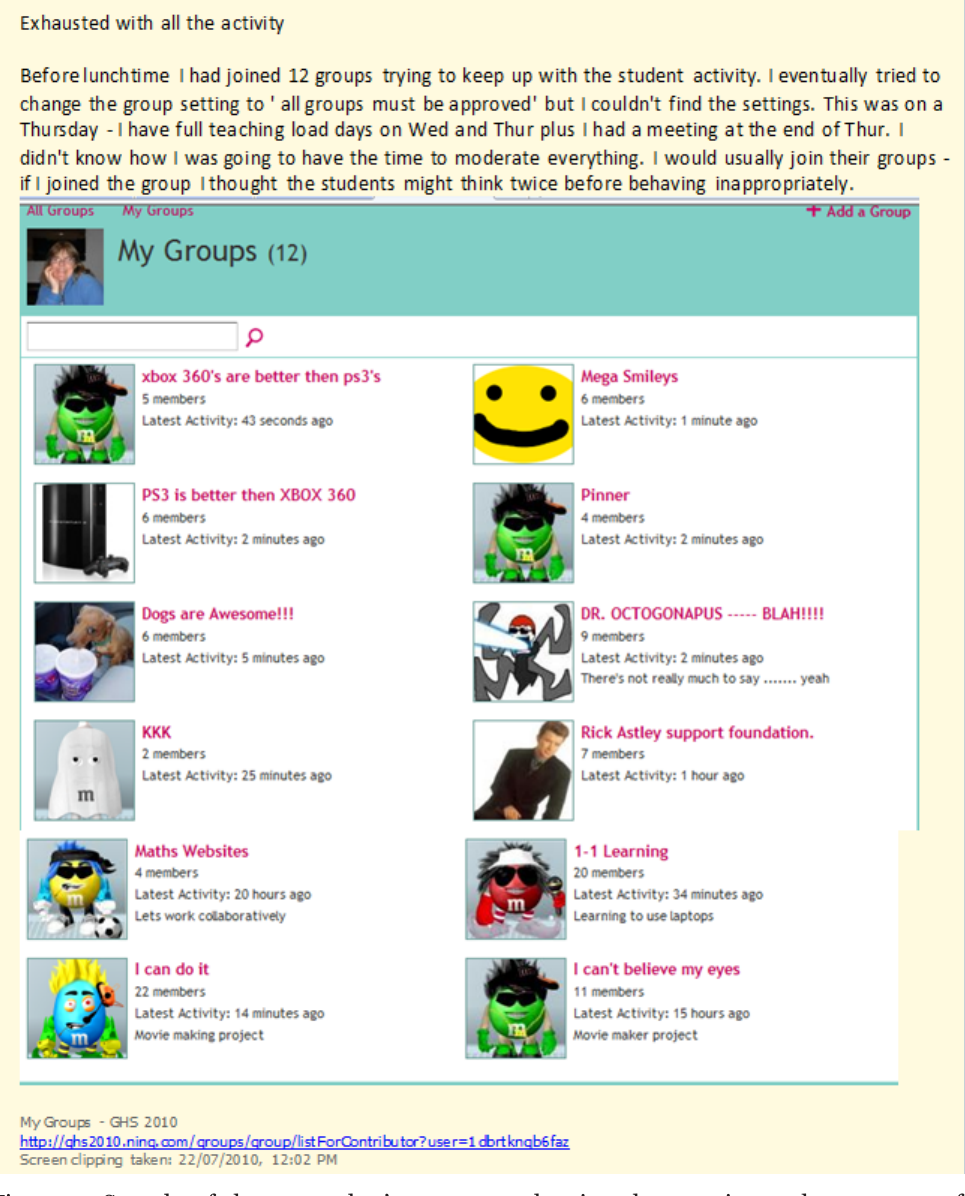
Figure 4. Sample of the researcher’s comment showing that, at times, the pressure of moderating the Ning became stressful due to the unpredictability of student